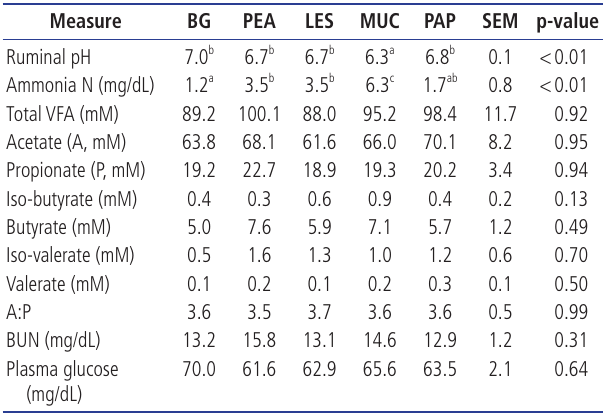
Table 5. Effects on ruminal fermentation indices, blood urea nitrogen (BUN) and plasma glucose concentrations in goats resulting from supplementing bahiagrass (BG) hay with perennial peanut (PEA), lespedeza (LES) hay, mucuna (MUC), or